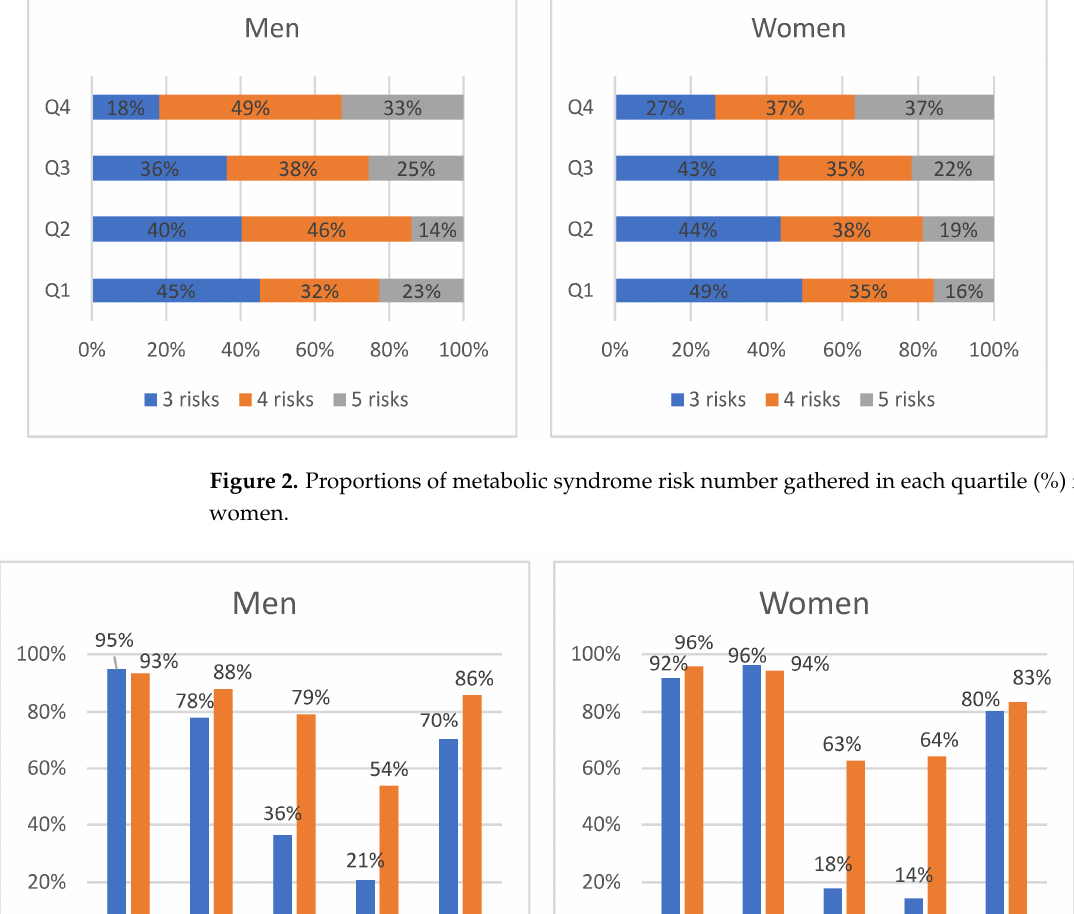
Figure 3. Metabolic syndrome components distribution according to the number of clusters (%) in men and women. BP—blood pressure; WC—waist circumference; TG—triglycerides; HDL-C—high-density lipoprotein cholesterol; PG—plasma glucose.